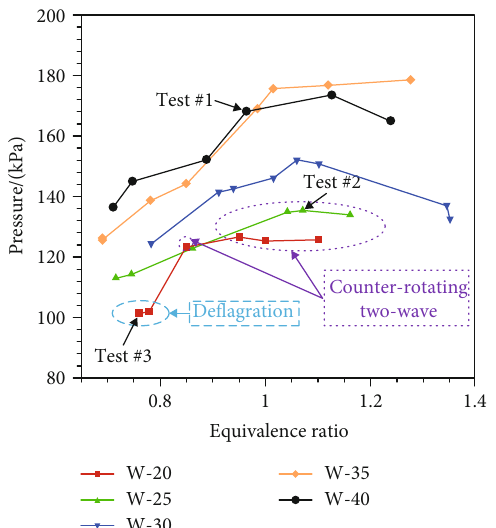
Figure 17: E ff ects of combustor width on propagation